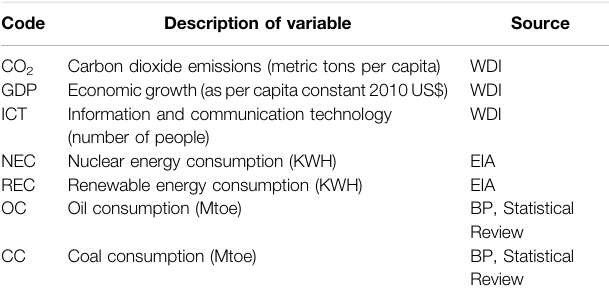
TABLE 2 | Ellipsis used for variables (British Petroleum, 2014; IEA, 2015; The World Bank, 2015; The World Bank, 2015; British Petroleum,